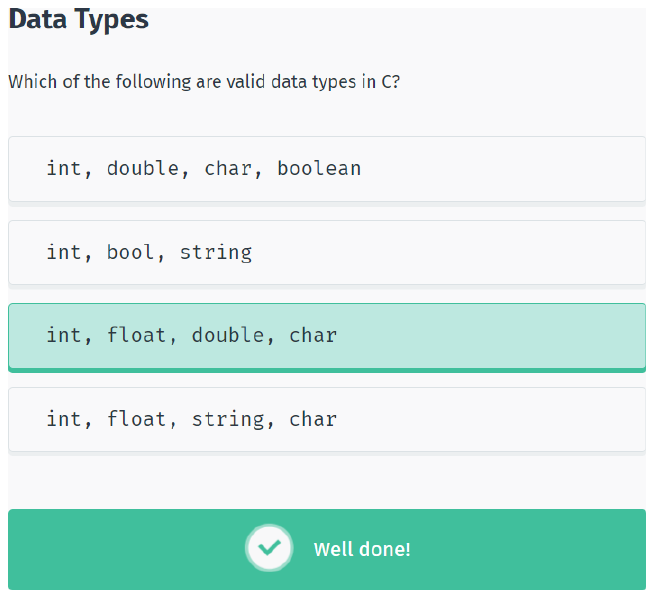
Figure 6: Choice of 1 correct